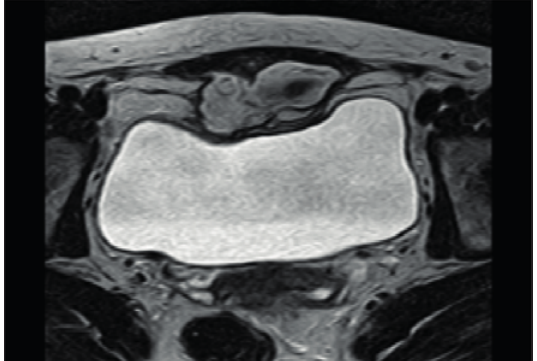
Figure 2. Post-contrast T1W axial pelvic MRI scan: Irregular hyper-intense mass invading rectus abdominis muscles, close to anterior bladder wall but without signs of infiltration was found